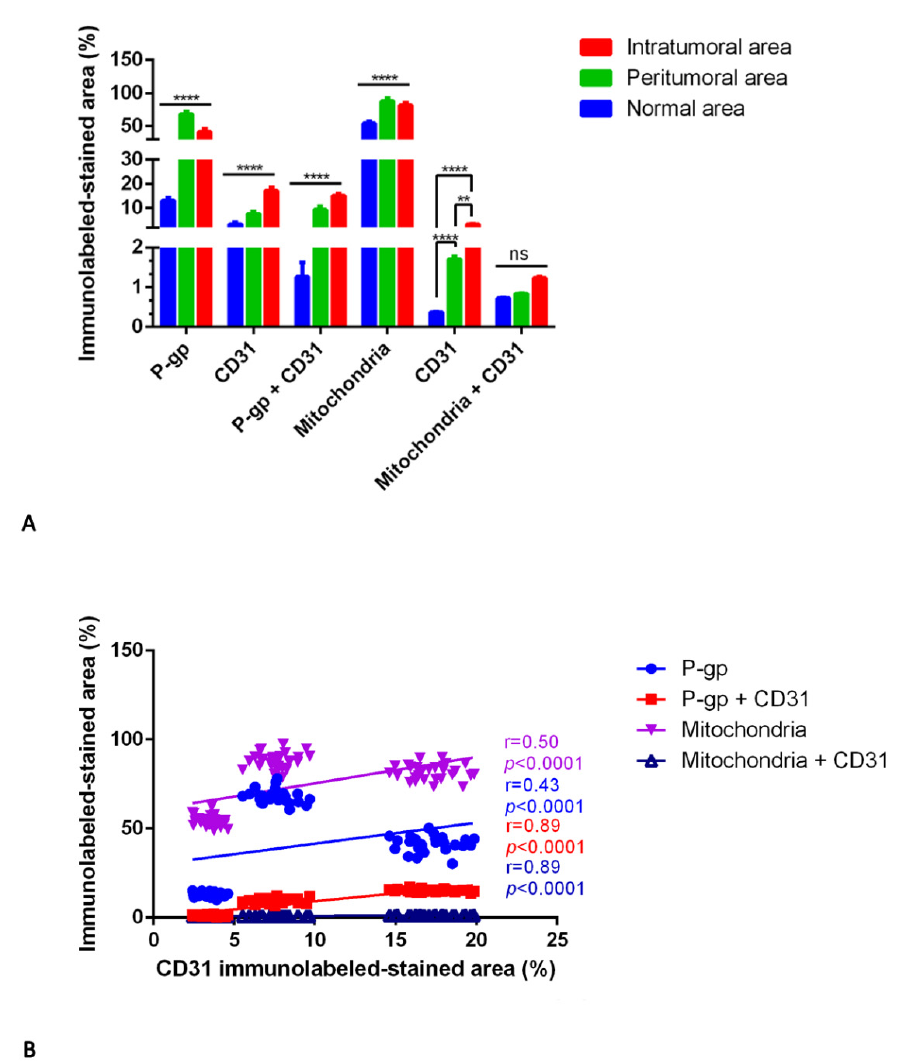
Figure 10. P-gp/CD31 and mitochondria/CD31 quantification in IDH-WT glioblastoma. P-gp, mitochondria and CD31 were evaluated by immunohistochemistry and were estimated as a percentage of digital quantification within the same spatial ROIs on IDH-WT glioblastoma serial sections using the colocalization algorithm. P-gp and mitochondria are significantly overexpressed in peritumoral areas versus the normal and intratumoral ones ( A ). CD31 and P-gp + CD31 progressively increased from normal to intratumoral areas. No significant differences are noted in mitochondria + CD31 expression in all three areas ( A ). Linear regression analysis ( B ) shows a positive and very strong statistical correlation between the CD31 expression and the P-gp + CD31 or mitochondria + CD31 co-expression ( B ). The CD31 correlation with P-gp or mitochondria is fair ( B ). [For P-gp: Y = 1.180*X + 29.77; for P-gp + CD31: Y = 0.9135*X + 0.02263; for mitochondria: Y = 1.481*X + 60.67; for mitochondria + CD31: Y = 0.03663*X + 0.5905]. Data are reported as mean ± SD, and the Tukey’s post hoc test was used to compare all groups after two-way ANOVA. N = 30. ns, not significative; ** p < 0.01; **** p < 0.0001.